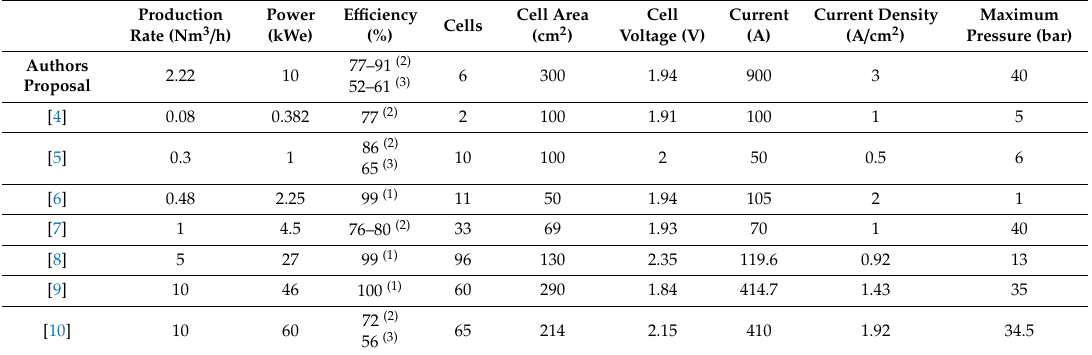
Table 2. Comparison of the findings of the proposed research with previous